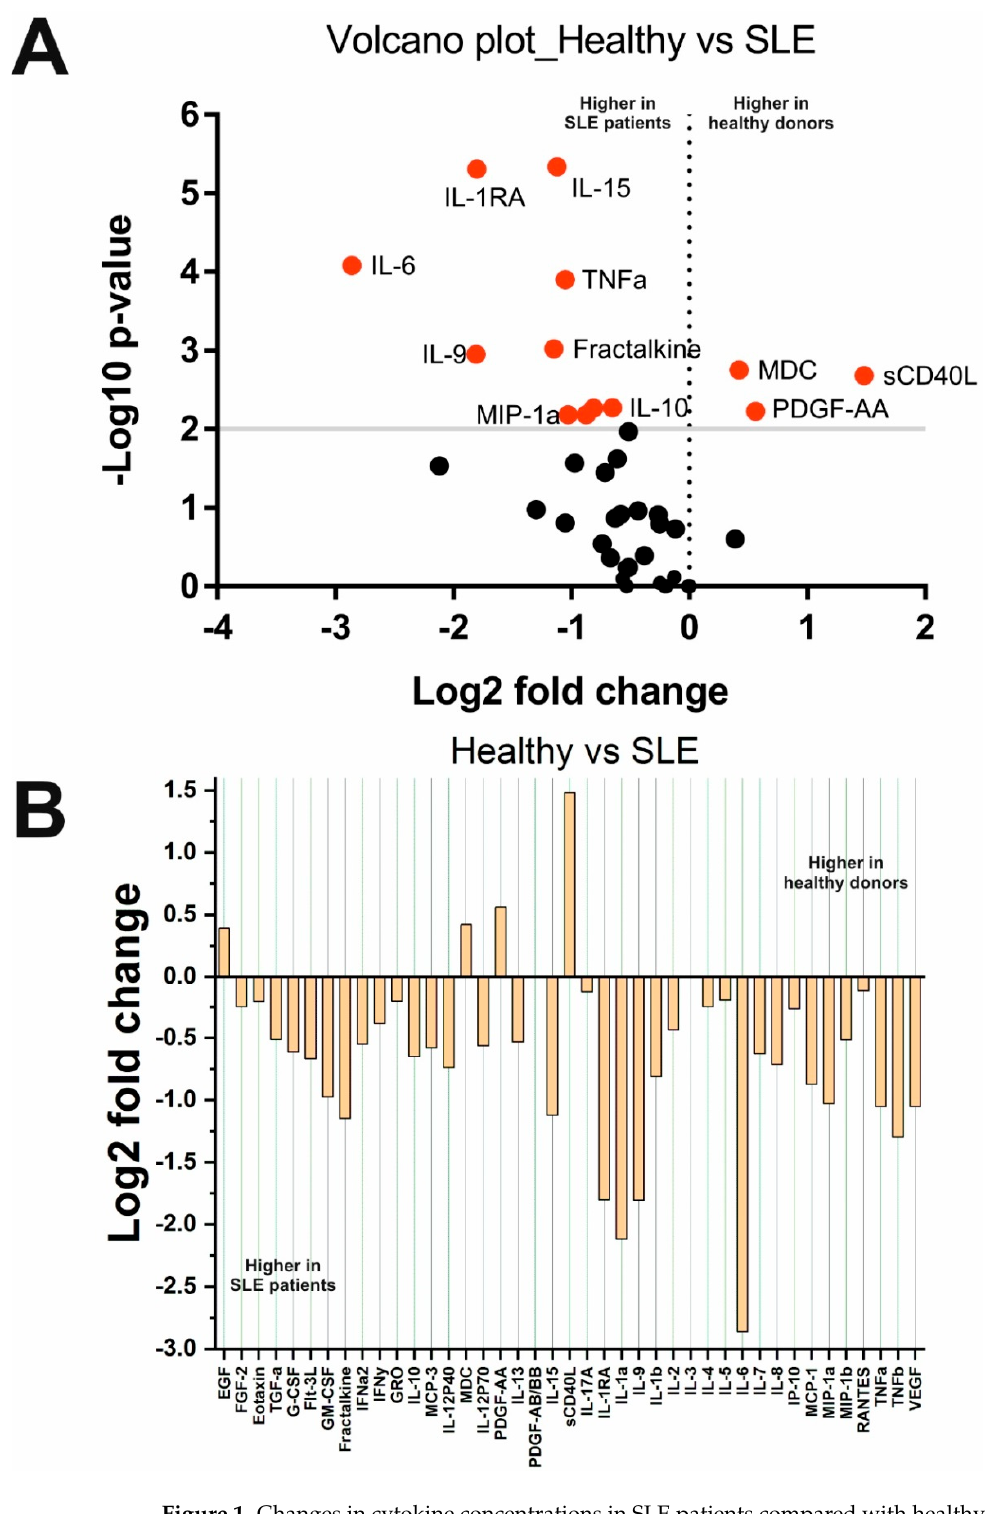
Figure 1. Changes in cytokine concentrations in SLE patients compared with healthy donors: ( A ) Volcano plot reflecting the dependence of Log2 fold change when pairwise comparing the median values in two groups from -Log10 p -value (red dots indicate significantly changed cytokines); ( B ) Log2 fold change in the concentration of 41 cytokines in the two